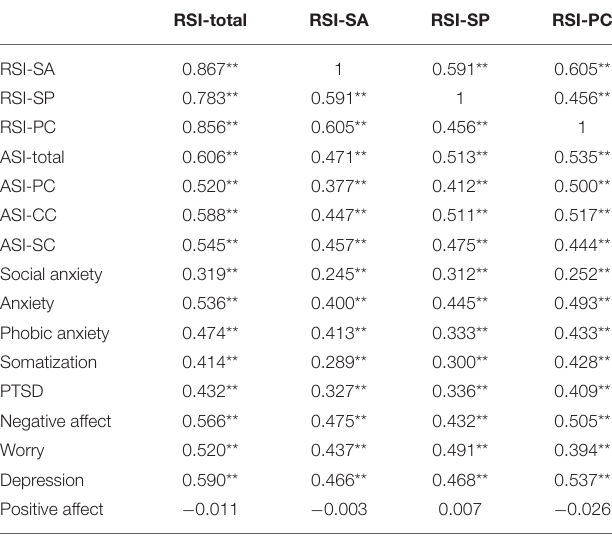
TABLE 6 | Zero-order correlations among the RSI scores and measures of validity. TABLE 7 | RSI and ASI-3 scores predicting relaxation-induced anxiety.